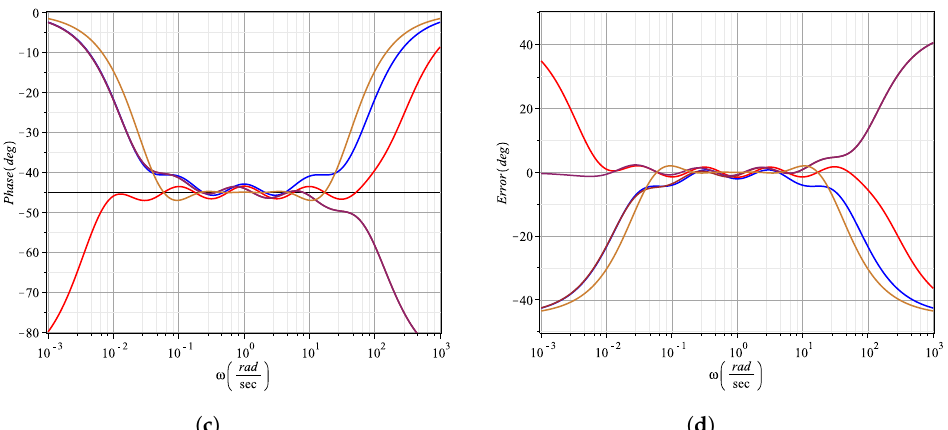
Figure 2. Ideal behavior (black line), Oustaloup’s (blue line), refined Oustaloup’s (red line), Charef’s V1 (brown line), ideal behavior (gray line) of (26), Charef’s V2 (maroon line) and Carlson’s (gold line) approximation for 1 . ( a ) Magnitude response. ( b ) Magnitude error. ( c ) Phase response. s 0.5 ( d ) Phase error.